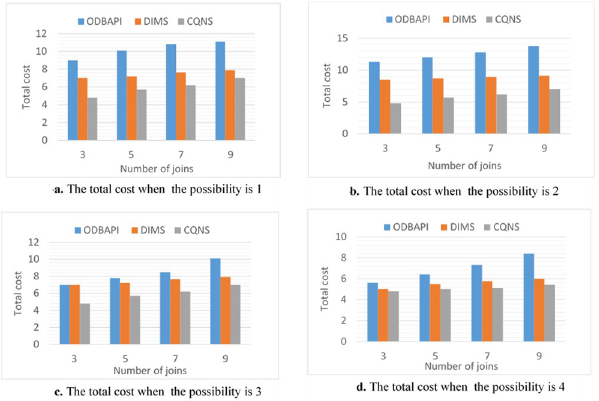
Fig 12. Comparison of possibilities 1 to 4 for ODBAPI, DIMS and CQNS on linear joins.